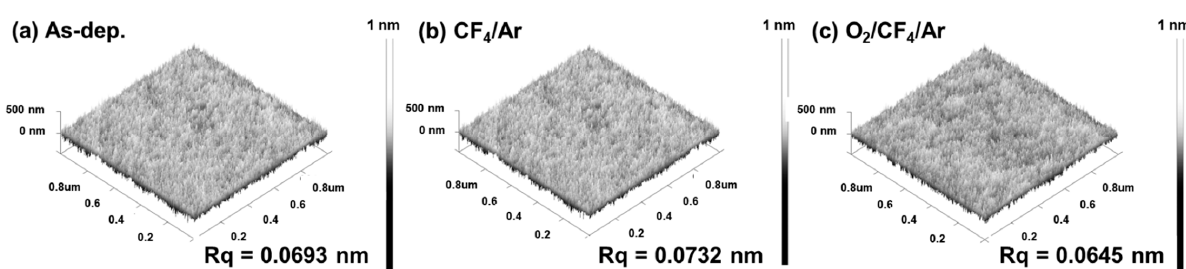
Figure 7. AFM image and root-mean-square values of roughness as a function of additive O 2 gas with fixed CF 4 /Ar = 25:75 sccm. ( a ) As-deposited IGZO thin film; IGZO thin film etched ( b ) using CF 4 /Ar plasma and ( c ) using O 2 /CF 4 /Ar plasma.